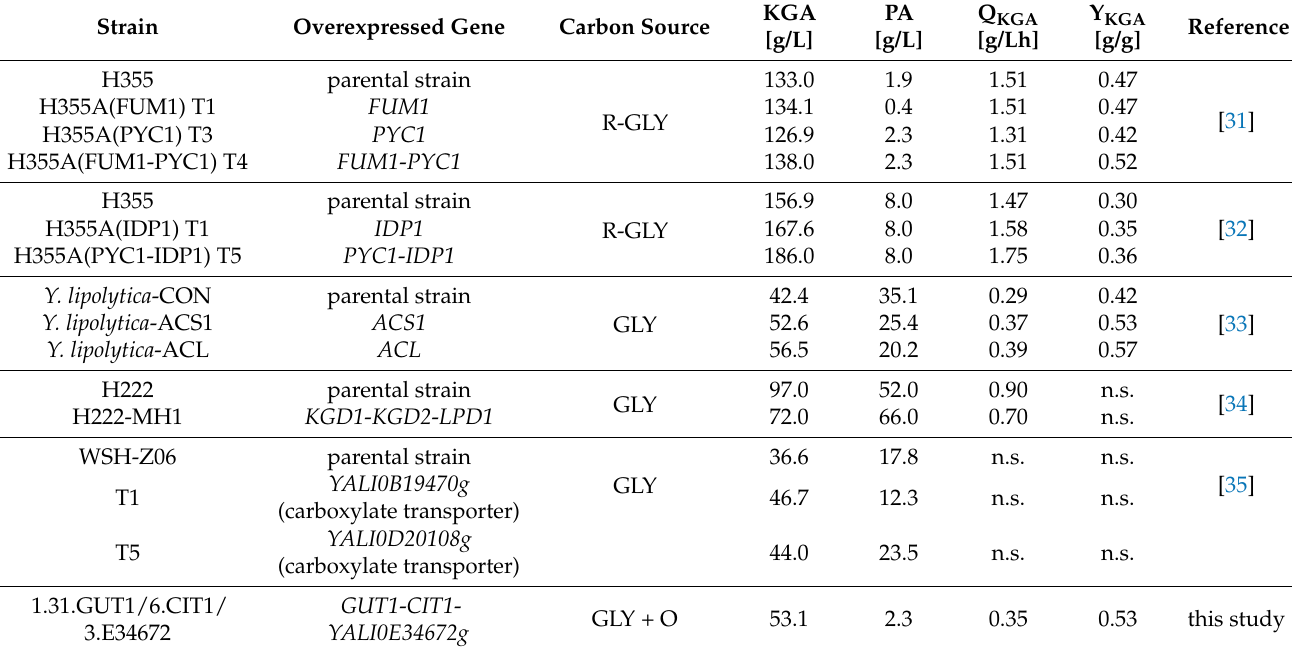
Table 6. The summary of prior studies on engineering Y. lipolytica yeast for enhancing the biosynthesis of KGA.